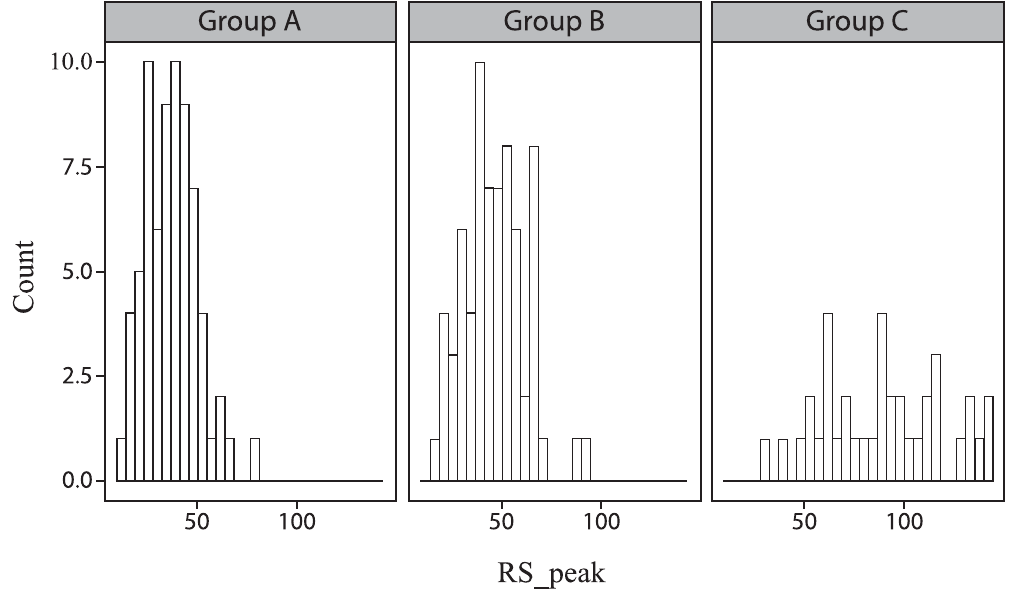
Fig 3. Histogram of the RS_peak predictors. A representative histogram of the RS_peak predictors for study participants enrolled in Group A, Group B, and Group